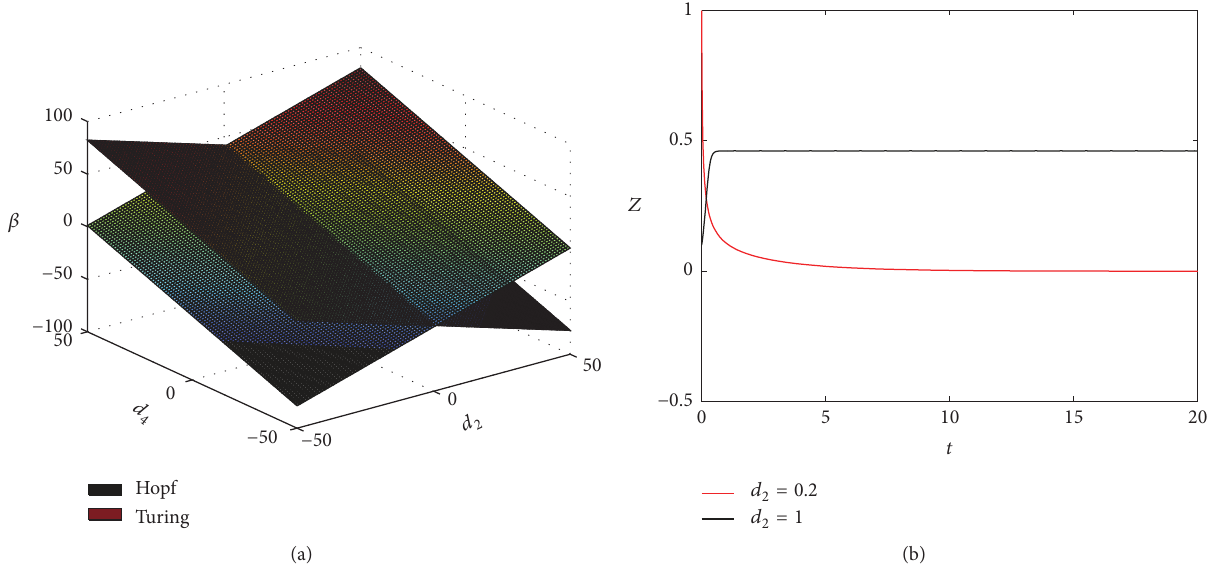
Figure 1: (a) The bifurcation space diagram. (b) The bifurcation space diagram based on (38) when 𝛼 = 3 , 𝛾 = 1 , 𝑑 1 = 1 , 𝑑 3 = 1 , 𝜎 = 1/2 , and 𝛽 = 2